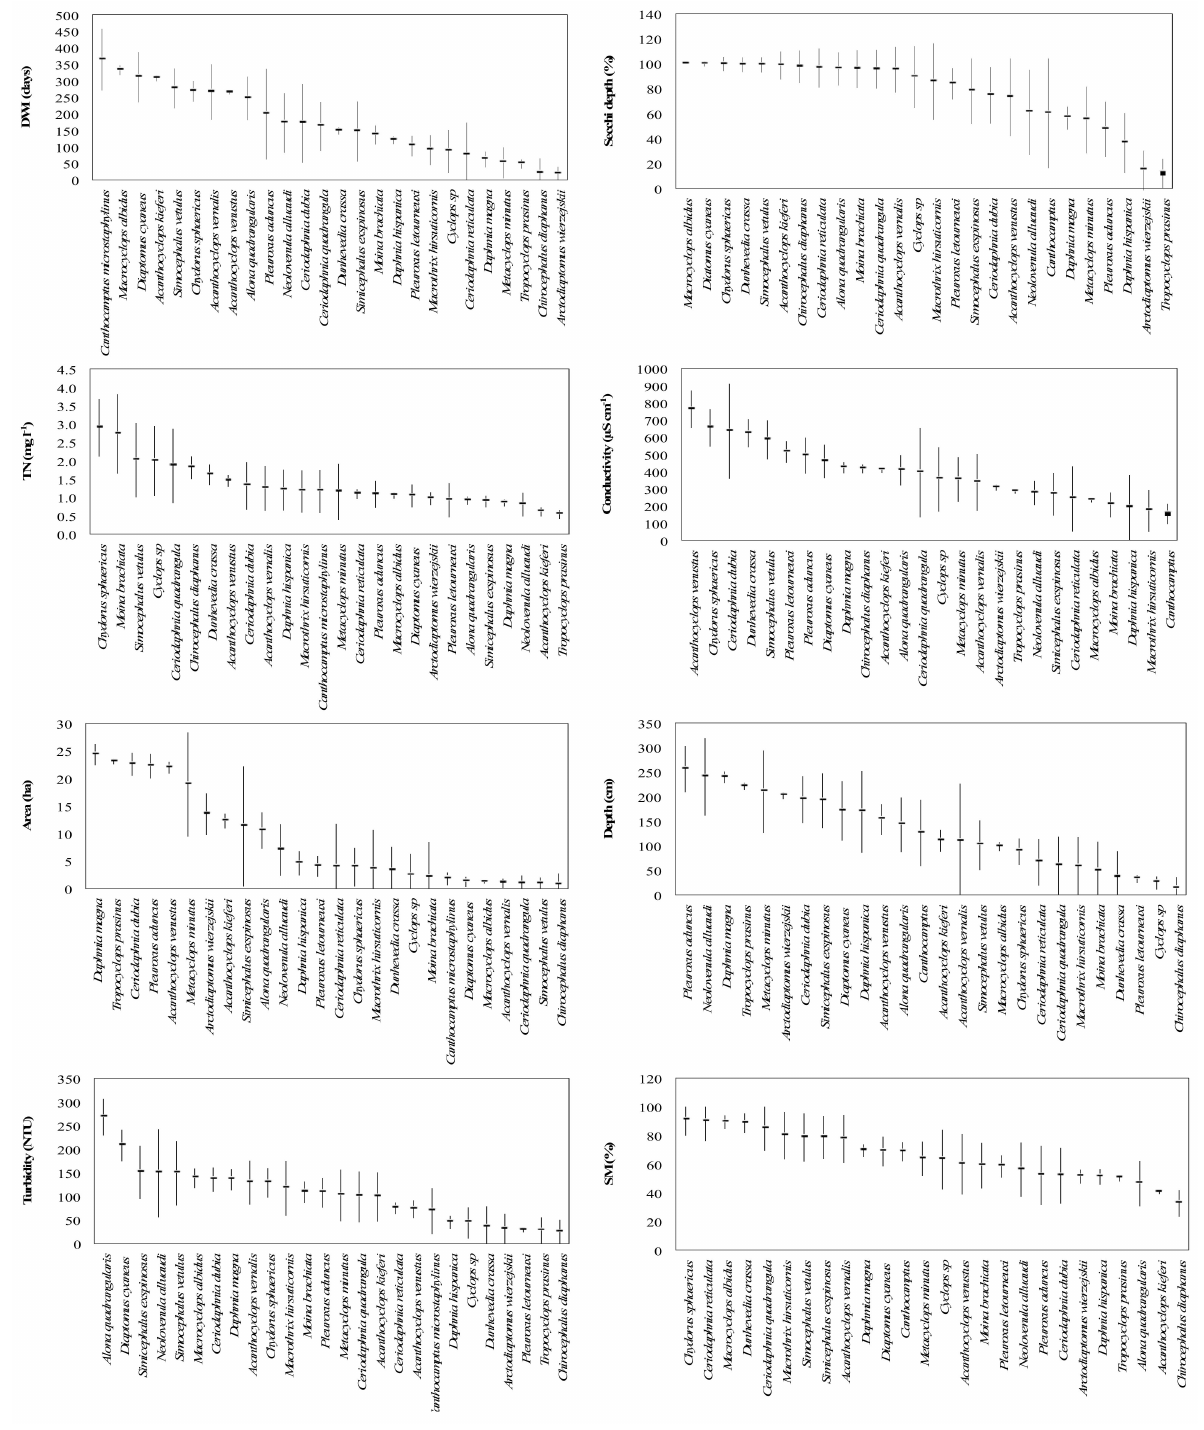
Figure 3. Optima (points) and tolerance (bars) of the most important variables extracted from the CCA analysis. The 26 taxa arranged in order of decreasing optima. The optima and tolerance for each environmental variable are represented in decreasing order of the optima for each taxon. Note that, as it was expected, the position of species in relation to selected variables is similar to that obtained in CCA analysis. Only the taxa present in more than 10% of samples were